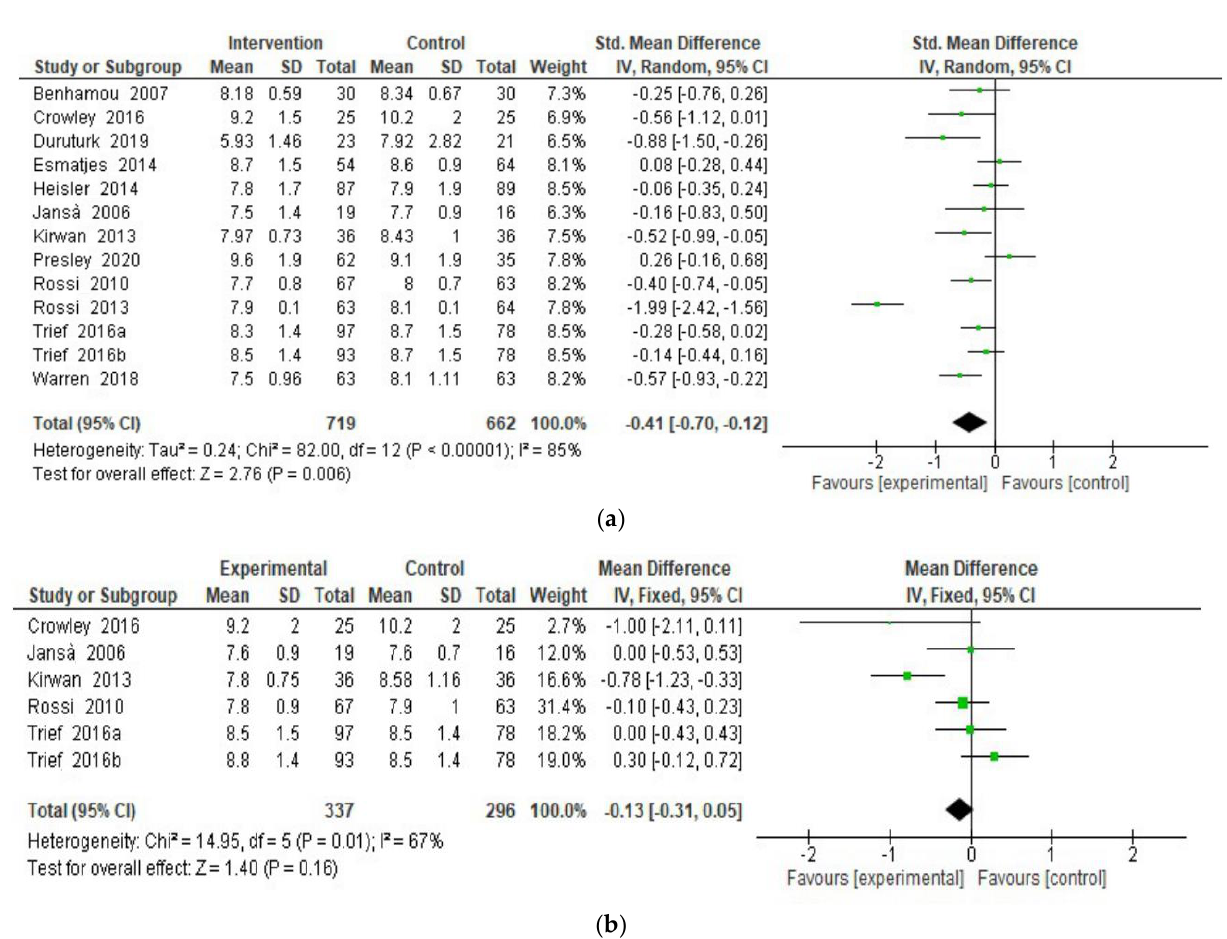
Figure 2. Risk of Bias color-coded.